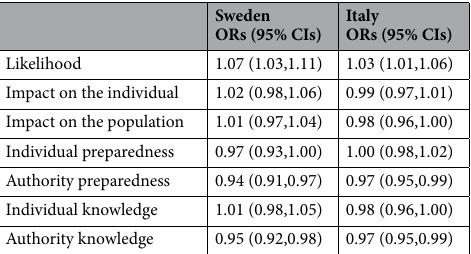
Table 3. Association between excess mortality (for each 10% increase) and domains of risk perceptions. Models adjusted for gender, age and relative income.